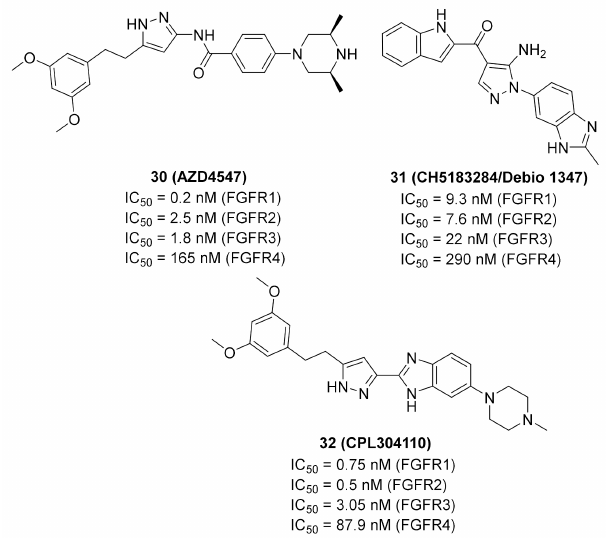
Figure 32. Structures of pyrazole-based FGFR inhibitors and their IC 50